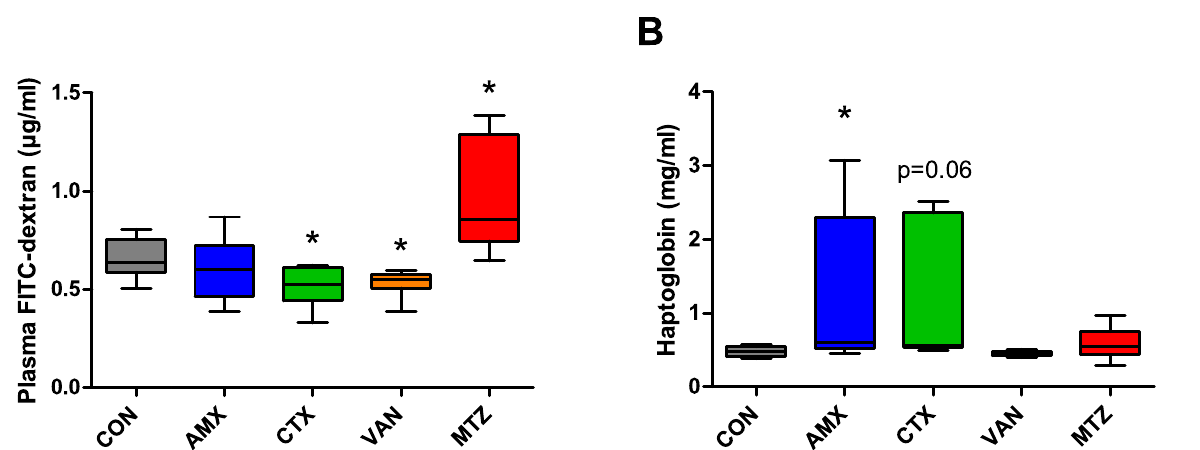
Fig 5. Blood plasma measurements. (A) Plasma FITC-dextran concentrations and (B) Haptoglobin concentration in blood plasma. Boxplots with whisker denoting the full ranges are shown. CON, control (grey); AMX, amoxicillin (blue); CTX, cefotaxime (green); VAN, vancomycin (yellow); MTZ, Metronidazole (red). Significant differences from CON group are indicated by asterisks ( * P < 0.05).